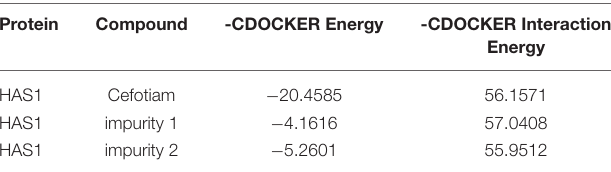
TABLE 4 | Docking